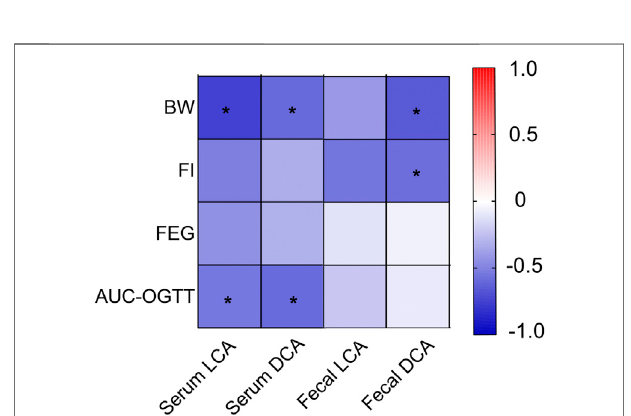
FIGURE 7 | Heatmap analysis of the Pearson correlation of serum and fecal BA and glucose homeostasis-related indexes. Red represents a positive correlation and blue indicates a negative correlation. Body weight (BW); Food intake (FI). * p < 0.05.